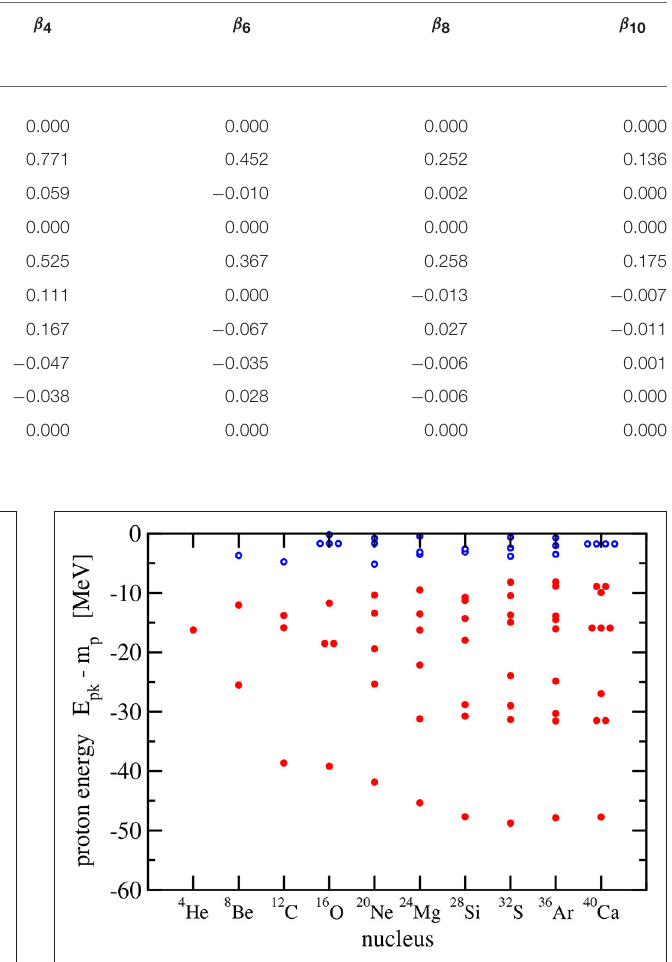
FIGURE 7 | Proton levels in the self-conjugated even-even nuclei 4 He - 40 Ca. Occupied levels (with two protons) are denoted by a full red circle and unoccupied levels by an open blue